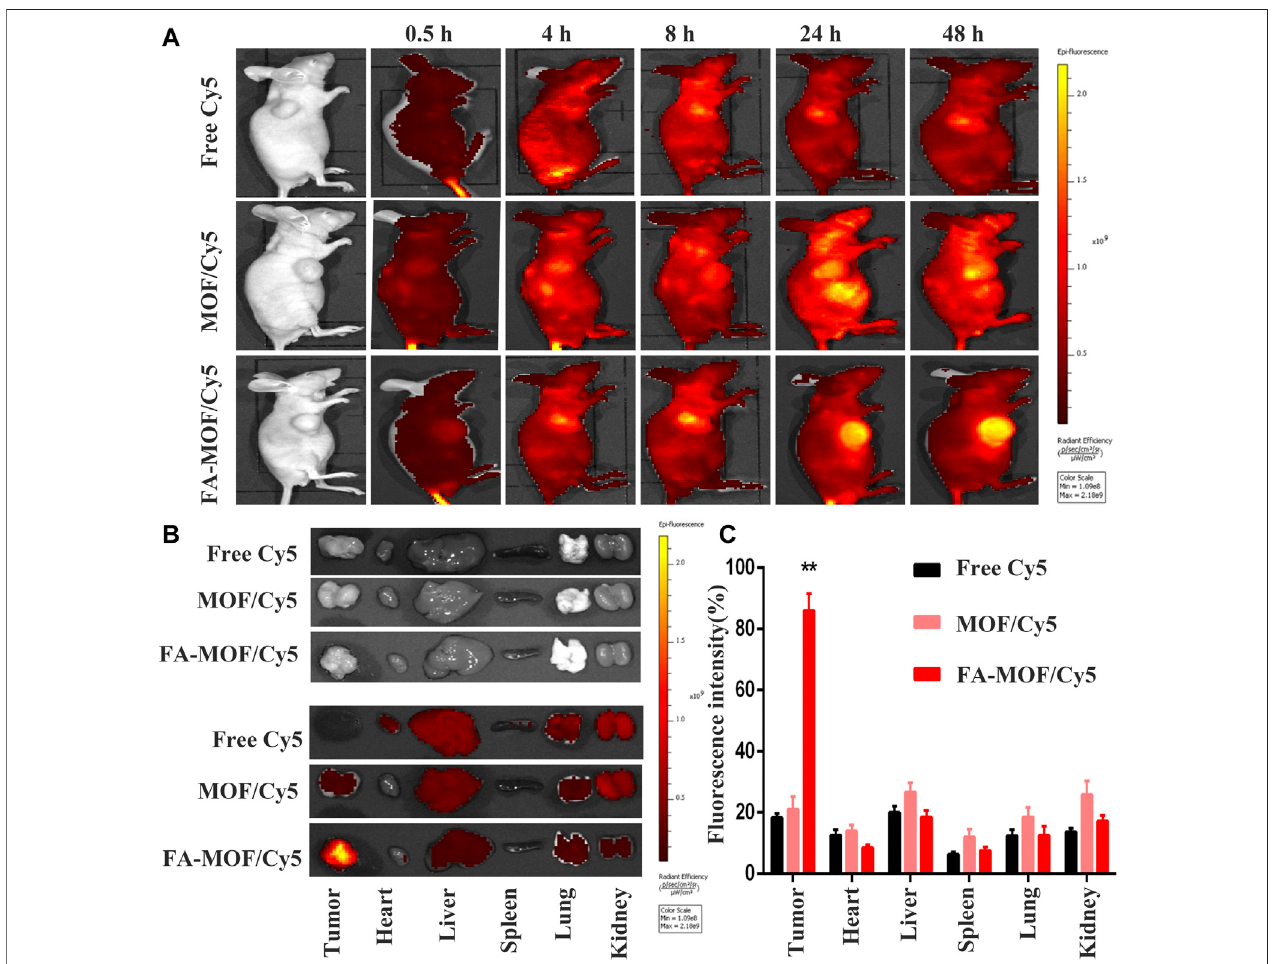
FIGURE 4 | In vivo fl uorescence imaging of tumor-bearing mice at 0.5, 4, 8, 24, and 48 h after intravenous injection; the decrease of fl uorescent intensities was indicated by the color bar from yellow to red (A) . Main organs, including heart, liver, spleen, lungs, and kidneys, and tumors were collected from mice at 48 h post injection for fl uorescence images (B) . Biodistributions of Cy5, MOF/Cy5, and FA-MOF/Cy5 in tumor issues and different organs. (C) ** p <